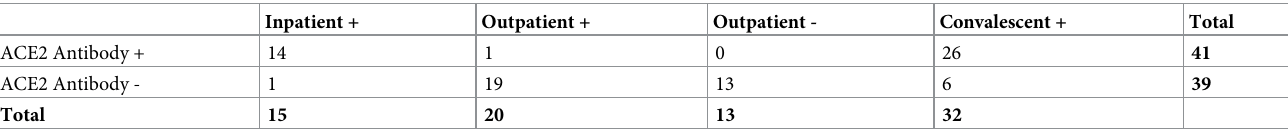
Inpatient + Outpatient